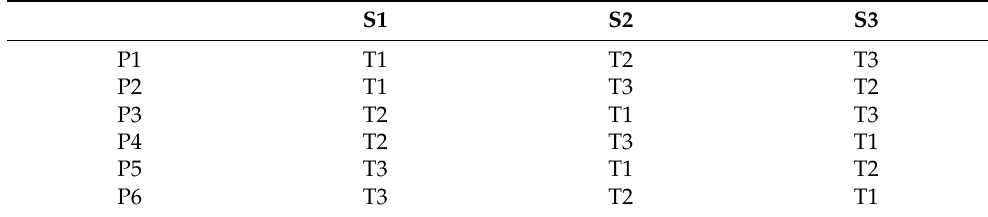
Table 5. Possible permutations considering the tasks and schedules of the project.